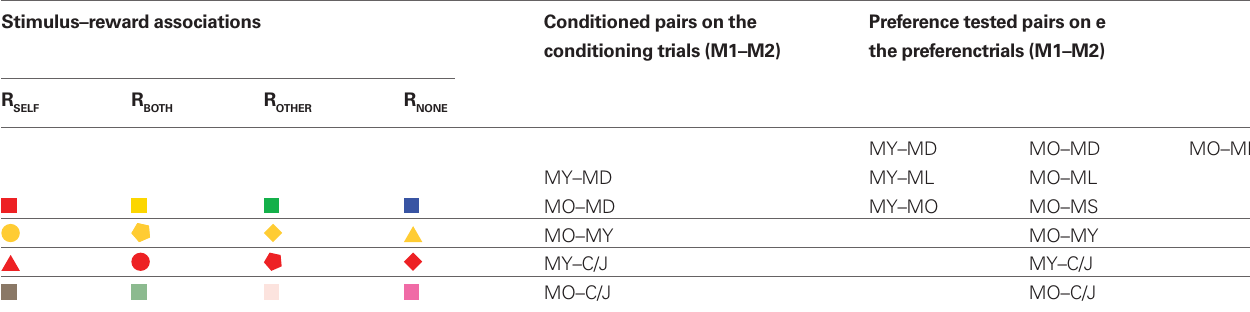
Table 1 | Stimulus–reward pairs used in the